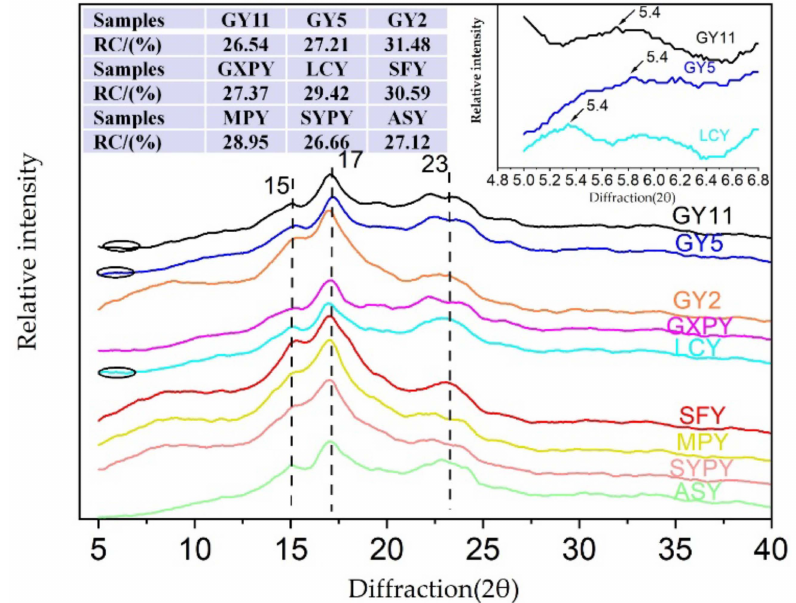
Figure 4. The X-ray diffraction spectra (XRD) of yam starch. Remark: RC: relative crystallinity. The relative crystallinity (RC) of each yam starch is shown in Figure 4. It can be seen that the RC of yam starch ranged from 26.54% (GY11) to 31.48% (GY2). The RC of the nine kinds of yam starch in this article is similar to the results of the DH (29.16%), DM-1 (28.56%), D.CJ (28.12%), and D.PP (28.10%) yam starches reported by Jiang [20], which were higher than D.RC (20.54%), D.XM (19.48%), DM-2 (19.37%), D.TG (18.97%), and D.BY (12.02%)